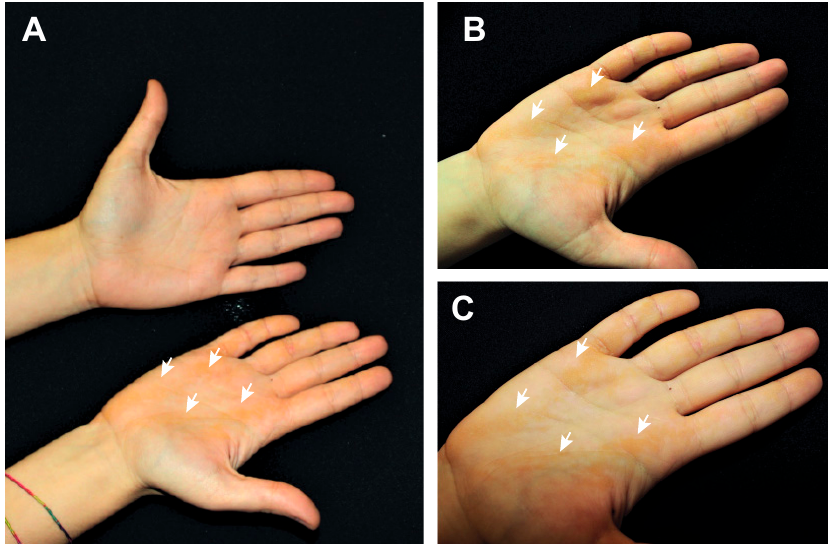
Figure 1. Patient presentation. ( A ), picture of both the patient’s hands showing hyperkeratotic lesions only in the right palm. ( B , C ) pictures of patient’s right palm showing the hyperkeratotic lesions (white arrows), with a nevoid distribution.